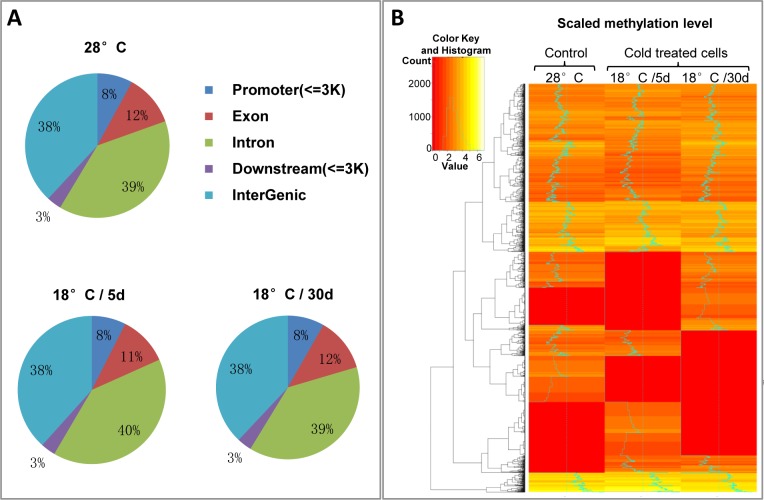
Variation of DNA methylation pattern of ZF4 cells under cold pressure.Genomic DNAs isolated from ZF4 cells cultured at 28°C, 18°C for 5 days and 30 days were subjected to MeDIP-seq analysis. A. Methylation peaks were distributed in promoter, exon, intron, downstream, intergenic regions as shown in the figure. B. Heat map of hierarchical clustering performed for all detected methylation peaks in all three samples shows variation of DNA methylation patterns under cold pressure. Each row represents a detected methylation peak.